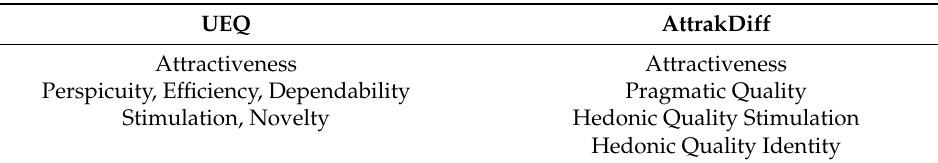
Table 1. Correlated dimensions between UEQ and